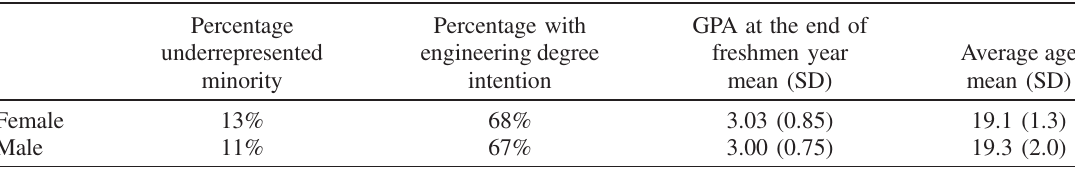
TABLE V. Key descriptive statistics for female and male students ’ race or ethnicity, major, GPA, and